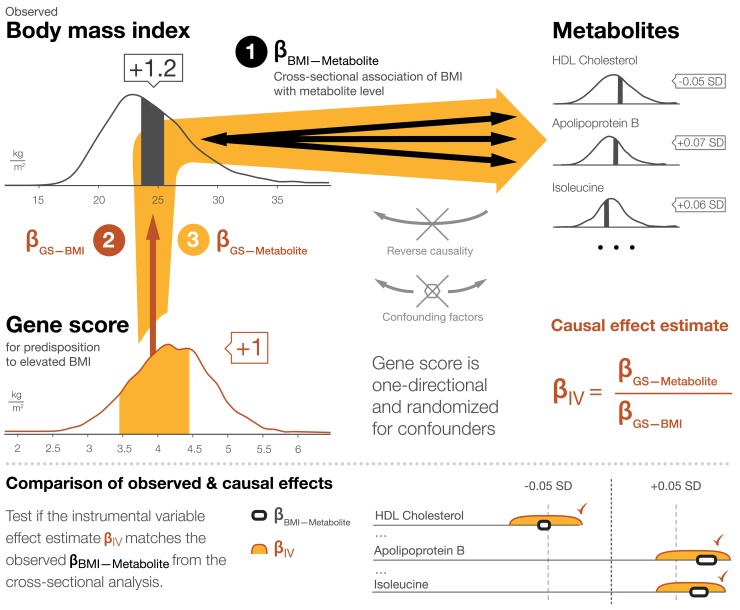
Mendelian randomization framework for estimating causal effects of BMI on the systemic metabolite profile.The principles of Mendelian randomization and core assumptions for the genetic instrument to be valid are detailed in Box 1.